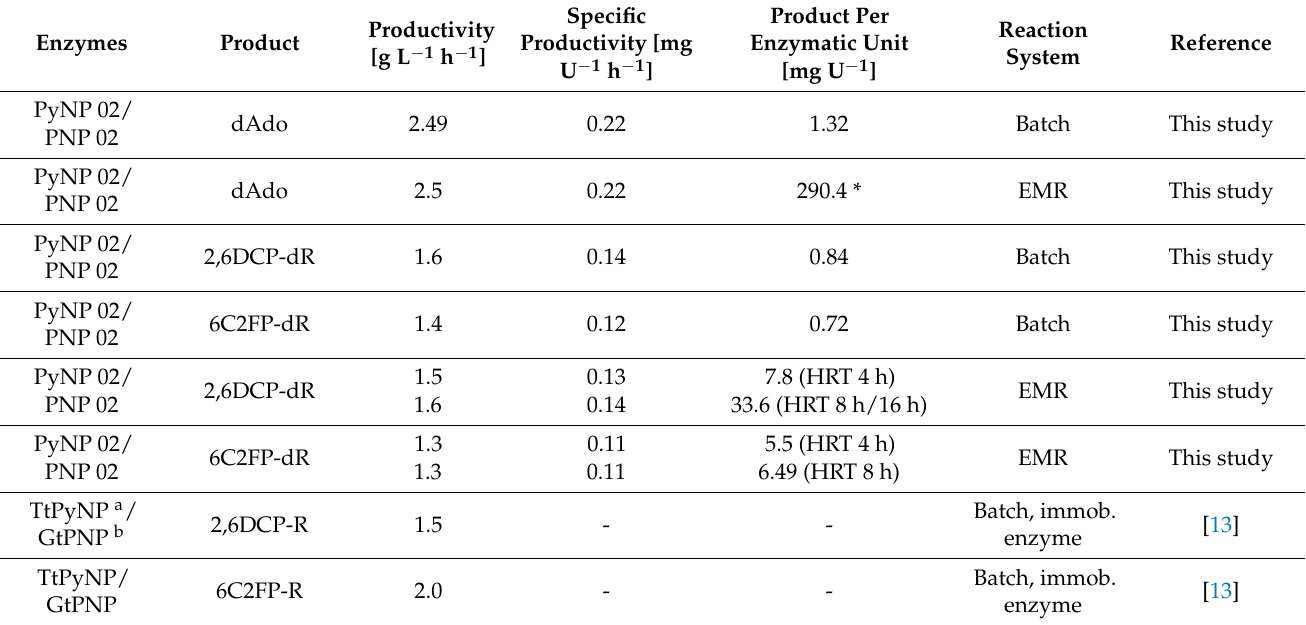
Table 1. Process parameters determined for the synthesis of dAdo and dihalogenated nucleosides. Parameters were calculated for steady state flow conditions in the EMRs. The threshold value of conversion was 55% substrate conversion for the calculation of process parameters for EMRs applied, to produce 6C2FP-dR and 2,6DCP-dR (see Figure 4).